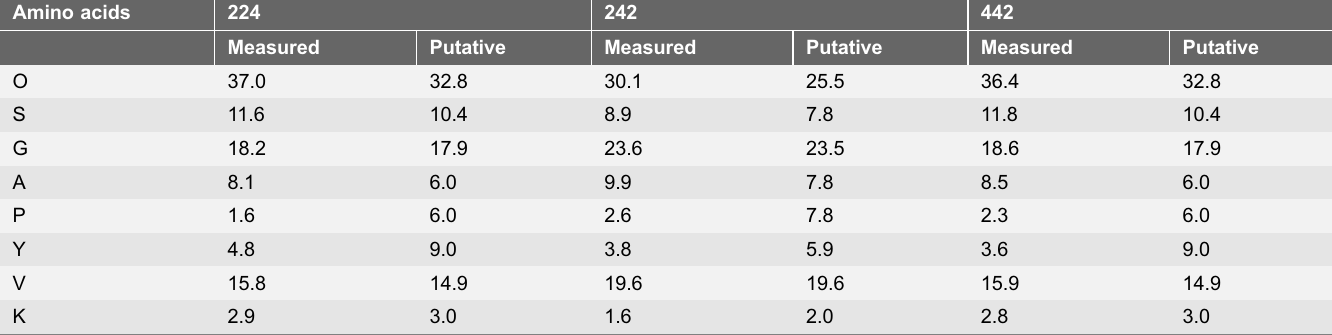
The data were shown as molar percentage and were average of two data sets. Amino acid residues in total weight percentage (w/w): 224, 13.5%; 242, 11.6%; 442, 11.7%. The low Y contents were due to the easy degradation of Y residues during hydrolysis.